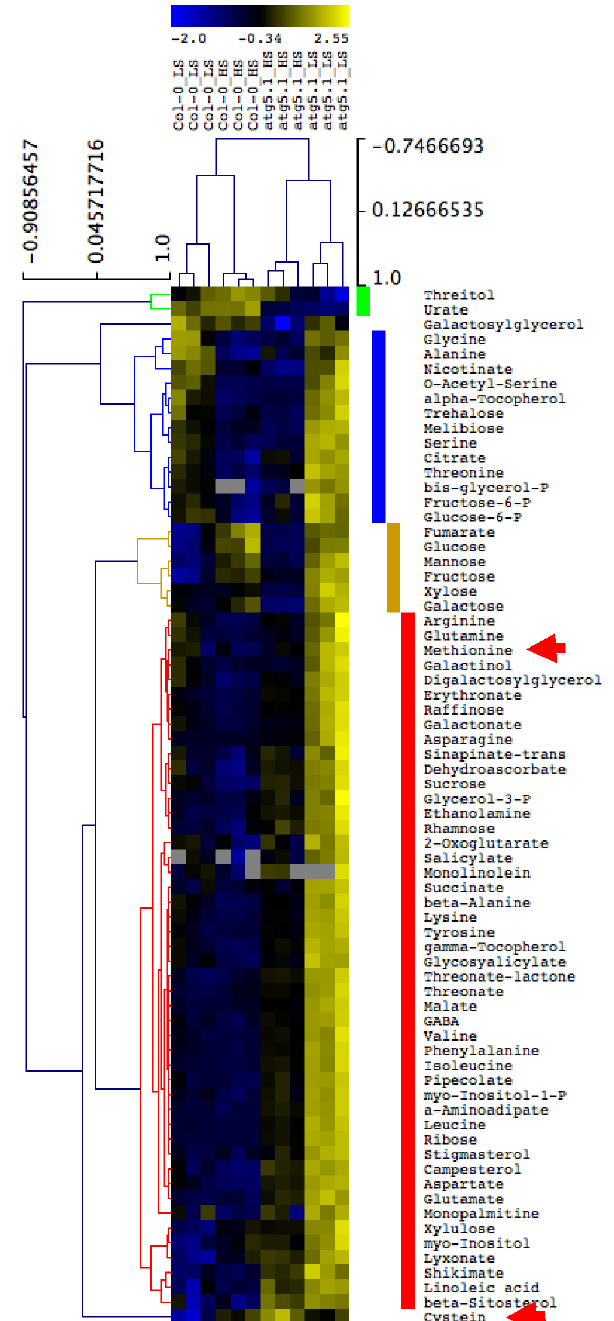
Figure 6. Hierarchic clustering of metabolite relative contents in atg5-1 and Col-0. Metabolite relative contents in the rosettes of atg5 and Col-0 wild type genotypes, grown under high sulphate and low sulphate conditions for 60 days, were measured using GC–MS. An ANOVA was performed to identify metabolites significantly modified by genotype or sulphate availability. The hierarchic clustering of significant metabolites was performed using MEV4. The clusters show metabolites less abundant in atg5 relative to Col-0 under both high and low sulphate conditions (green), less abundant in atg5 relative to Col-0 under high S but more abundant under low S (orange), more abundant in atg5 relative to Col-0 under both high and low sulphate conditions (red), and not di ff erent in atg5 and Col-0 but modified by sulphate availability (blue). The red arrows indicate the position of cysteine and methionine. Three biological repeats are shown for each genotype and